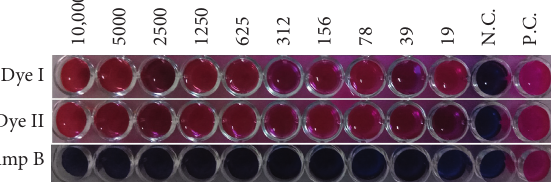
Figure 5: In vitro antileishmanial activity Leishmania tropica promastigotes; dye I, dye II, control drug amphotericin B, and dilution concentrations 10,000–19 μ g/mL. NC: negative control and PC: positive control.